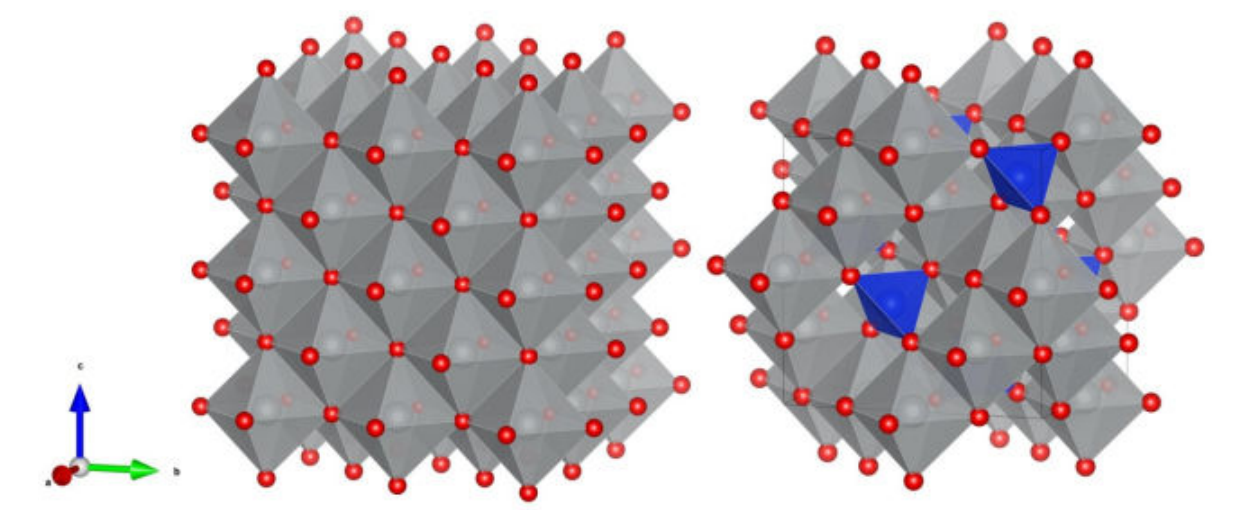
Figure 5. NiO structure ( left ); Ni 2 SiO 4 structure ( right ) in cubic axes. Red ball indicates oxygen atom; grey—Ni, blue—Si.